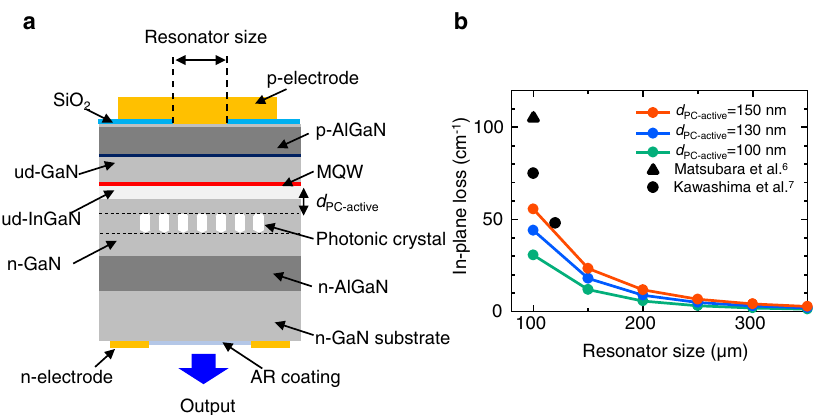
Fig. 1 In-plane losses of GaN-based PCSELs. a Cross-sectional schematic of the GaN-based PCSEL structure. b 3D-CWT-based analysis of in-plane loss versus resonator size for a family of distances d PC-active between the photonic crystal layer and the